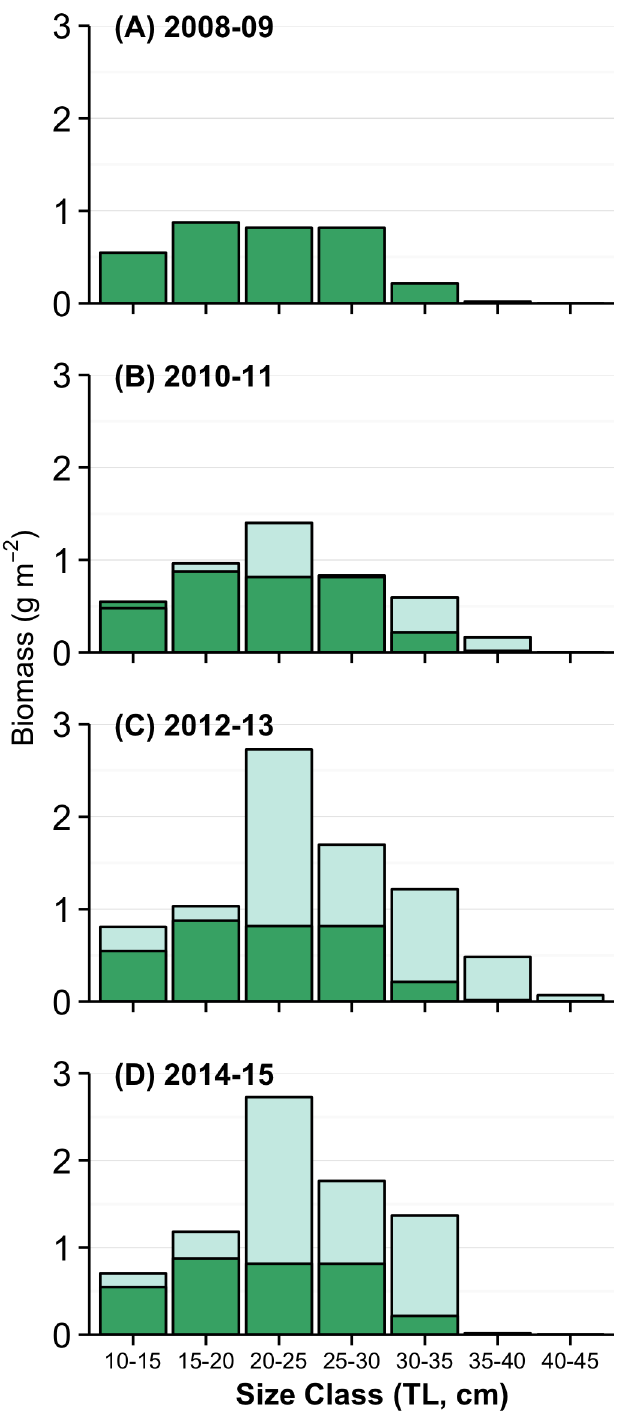
Fig 4. Size distribution of parrotfishes 10cm and above, pooled into 2-year periods. 2008 – 9 represents size distribution before closure. The dark green columns in all figures represent biomass per size class in 2008 – 9, and are shown in later figures to highlight differences between 2008 – 9 and later time